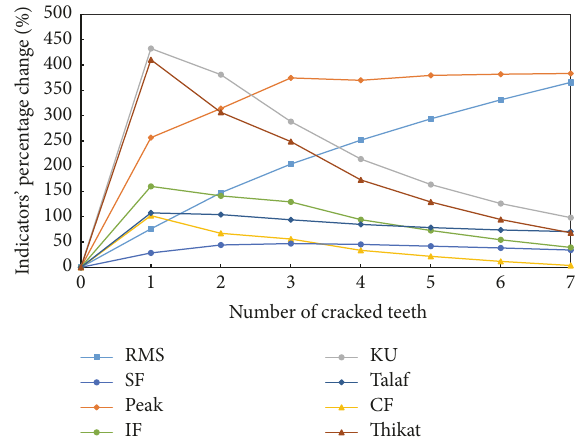
Figure 28: Performance of different time domain indicators applied to the residual signal for the second multiple-crack scenario.